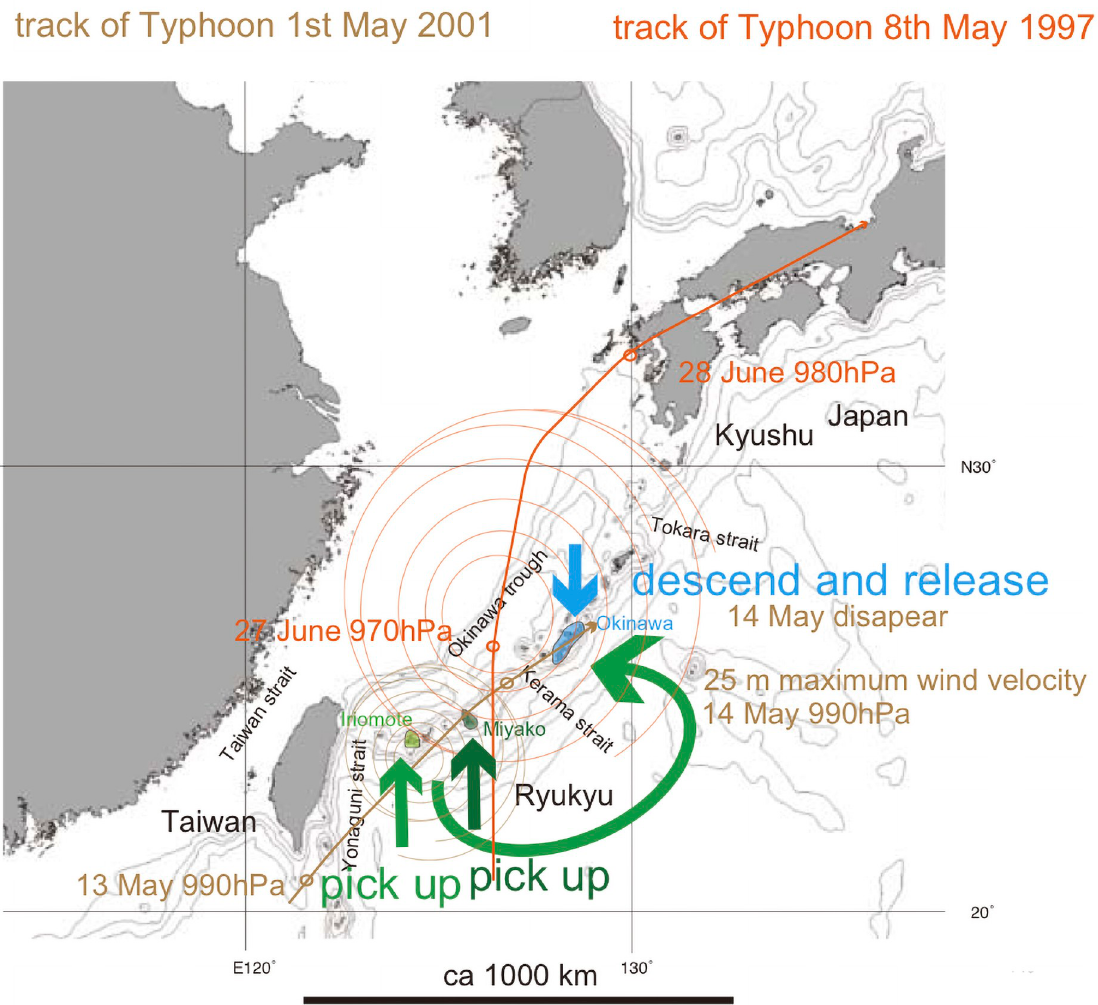
Fig 14. Track of Typhoon 1, May 2001 (brown curved path), that may have transported and then released Mogannia minuta on 14 May when it was lost energy west of Okinawa. The track of Typhoon 8, May 1997 (orange curved path), is also shown, because this typhoon also followed a path that may have transported M . minuta from the southern Ryukyu islands to Okinawa. The green path depicts this hypothetical transport. The bold short arrows schematically (not to scale) show where the typhoon winds picked up cicada (green and dark green) and where the same cicada were released (blue). Base map from Vector Map (VMap) Level 0, National Geospatial-Intelligence